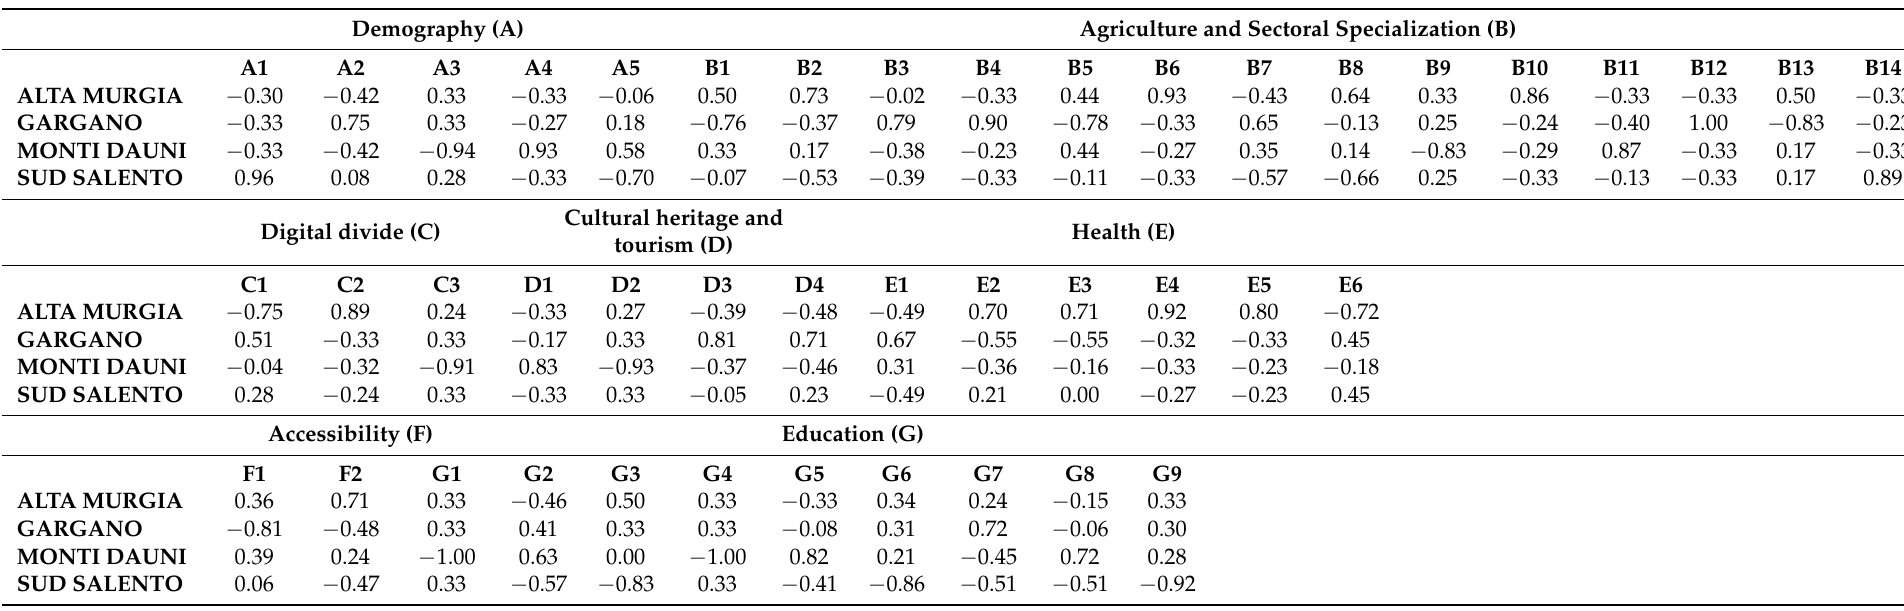
Table A2. The unicriterion net flow ( ϕ j ) showing the performances of the inner areas for each indicator and thematic